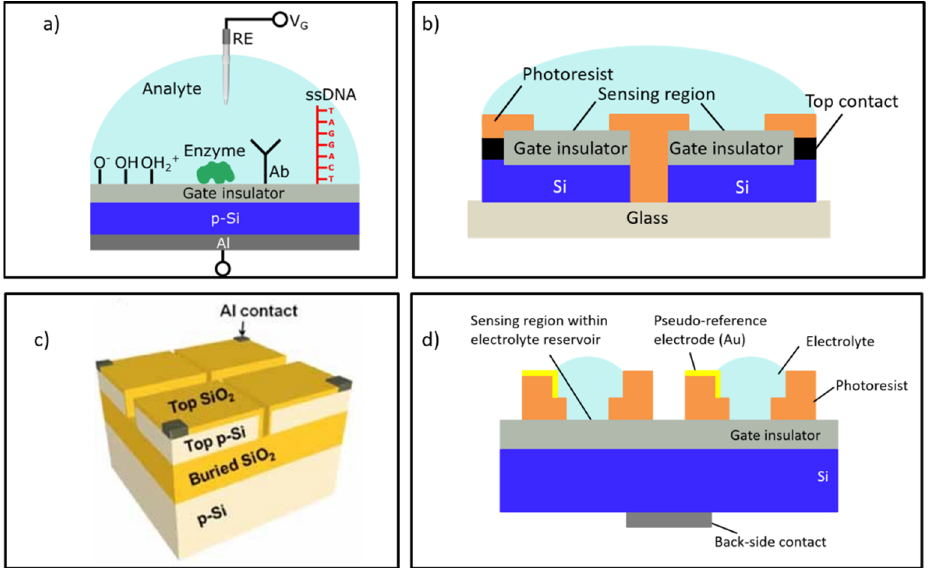
Figure 1. ( a ) Schematic structure of a conventional single EISCAP biochemical sensor with different receptor functionalities (reproduced from [15], open access publication under CC BY license); ( b ) layout of an EISCAP sensor array fabricated on a Si wafer anodically bonded to the glass substrate; ( c ) schematic of a chip combining a 2 × 2 array of nanoplate EISCAPs prepared on a SOI substrate (reproduced from [23] with permission from John Wiley and Sons); ( d ) design of an array of EISCAPs separated via the electrolyte reservoirs fabricated on the gate surface (schematically). RE: reference electrode, V G : gate voltage, Ab: antibody, ssDNA: single-strand deoxyribonucleic acid.